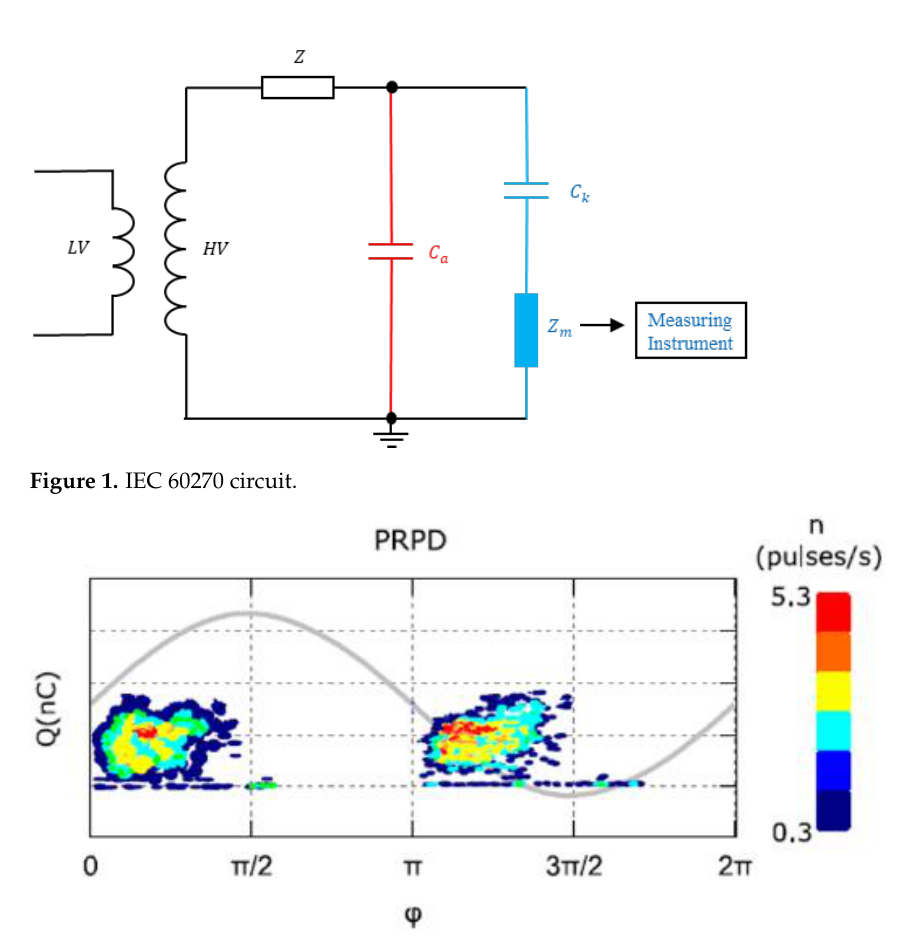
Figure 2. PRPD representation [51].